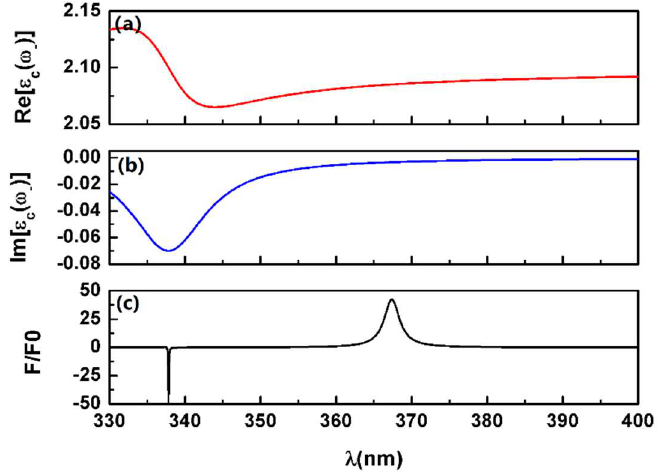
Figure 7. Real ( a ) and imaginary ( b ) parts of ε c ( ω ) in the case of a low aspect ratio ( a/b = 0.2) of Figure 2c with ε cg = − 0.07 and h = 0. ( c ) The same as Figure 3a but using the present ε c ( ω ) . Parameters: